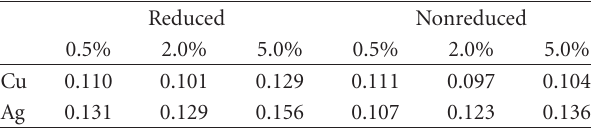
Table 1: The rate constant of reduction and nonreduction on the Cr(VI) concentration after the doping of metallic ions.